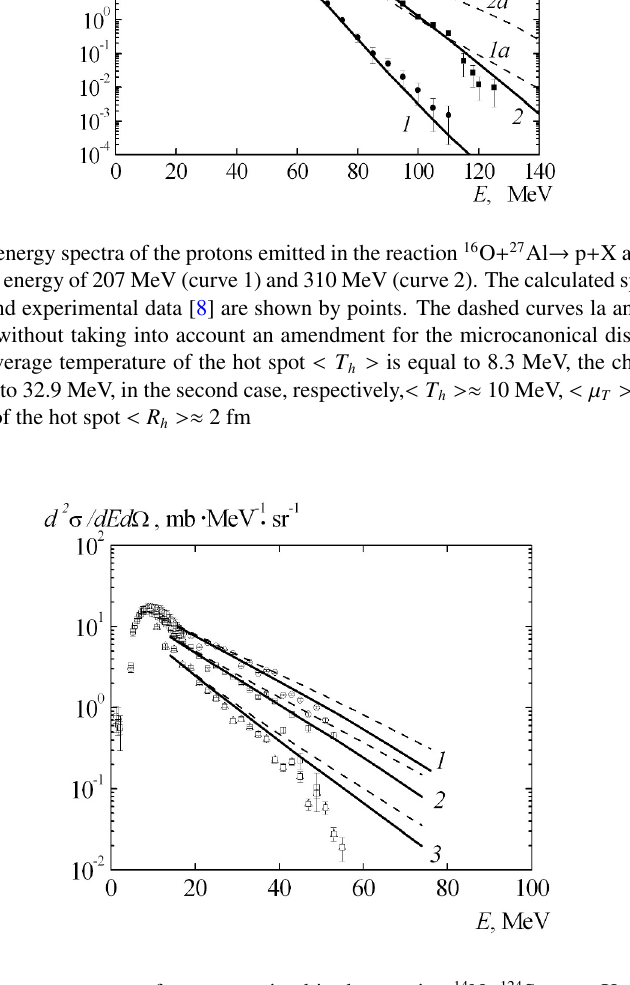
Figure 2. The energy spectra of protons emitted in the reaction 14 N + 124 Sn → p + X calculated with a non-equilibrium equation of state (solid lines) and experimental data (points from [14]) with the 14 N ion energy of 32 MeV / nucleon at an angle of 45 o (curve 1), 62 o (curve 2) and 90 o (curve 3). In this case, < T h > ≈ 11.4 MeV, < µ T > ≈ 30 MeV, < R h > ≈ 3 fm. The dashed curves correspond to the calculations for the traditional equilibrium equation of state. In this case, relaxation factor q =